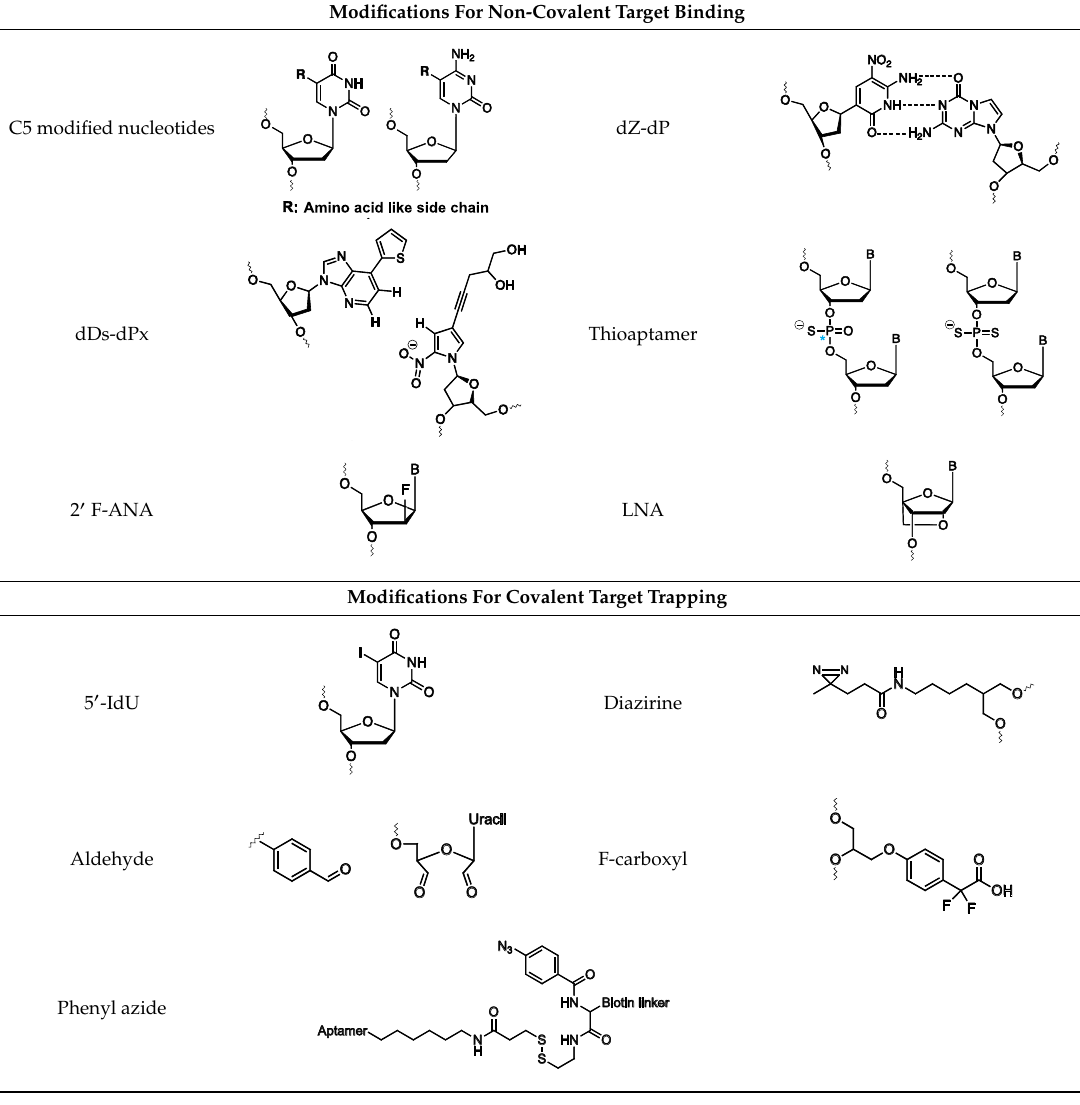
Table 1. Overview of aptamer modifications discussed in this review. dZ — 6-amino-5-nitro-3-(1 ′ - β -D- 2 ′ -deoxyribofuranosyl)-2(1H)-pyridone;